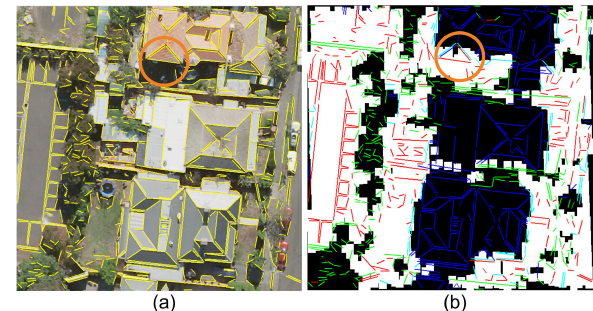
Figure 4: Image lines: (a) extracted and (b) classified (green: ‘tree’, red: ‘ground’, cyan: ‘roof edge’ and blue: ‘roof